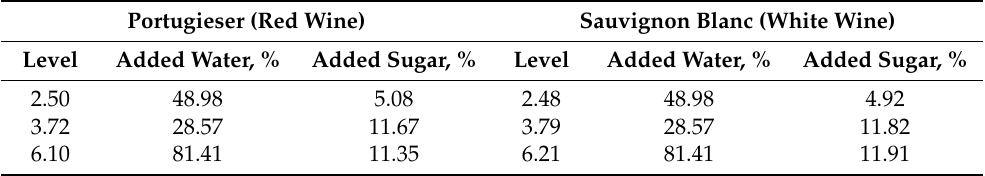
Table 2. Wine adulteration using a mixture of water dilution ( v / v ) and added sugar ( m / m ). Portugieser (Red